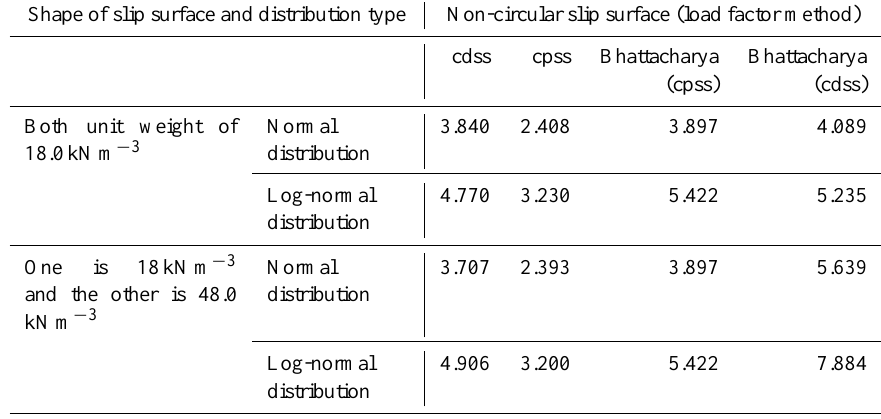
Table 6. Summary of reliability indices for the problem in Fig. 11 (soil number from top to bottom). Shape of slip surface and distribution type